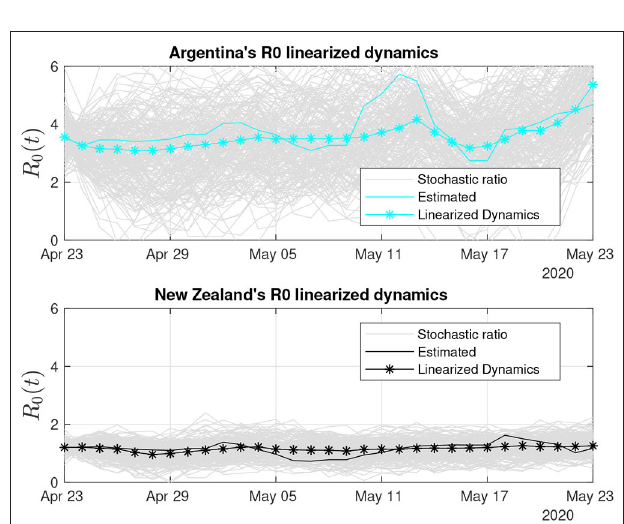
FIGURE 11 | Thirty days of linearized R 0 dynamics for Argentina and New Zealand. New Zealand has been able to control its COVID-19 infection rate, which is reflected on the low variability of the stochastic ratio curve.